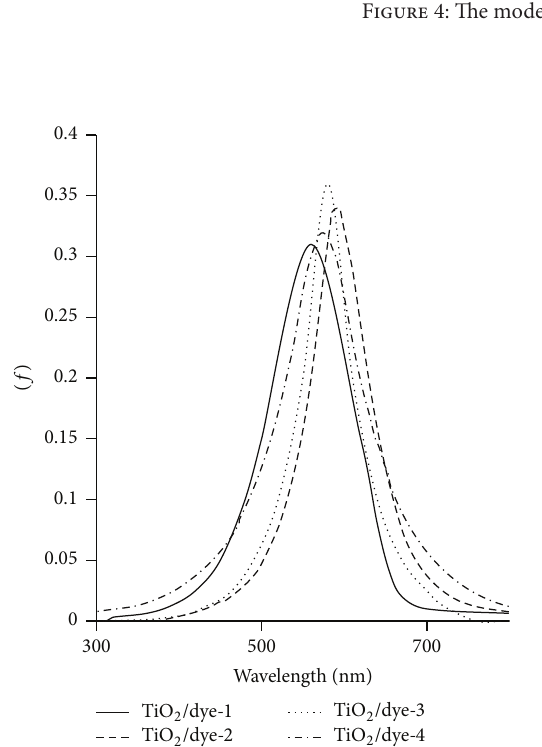
Figure 5: Simulated absorption spectra of (TiO 2 ) 8 /systems 1–4.